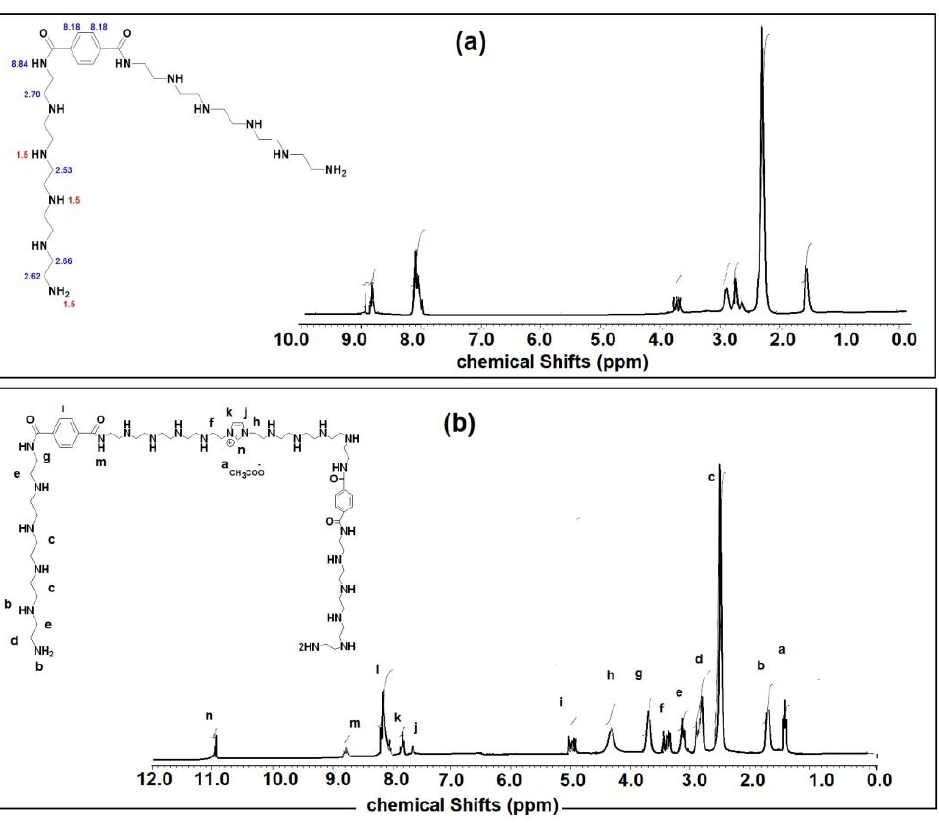
Figure 3. 1 HNMR spectra of ( a ) APA and ( b ) PAIIL.